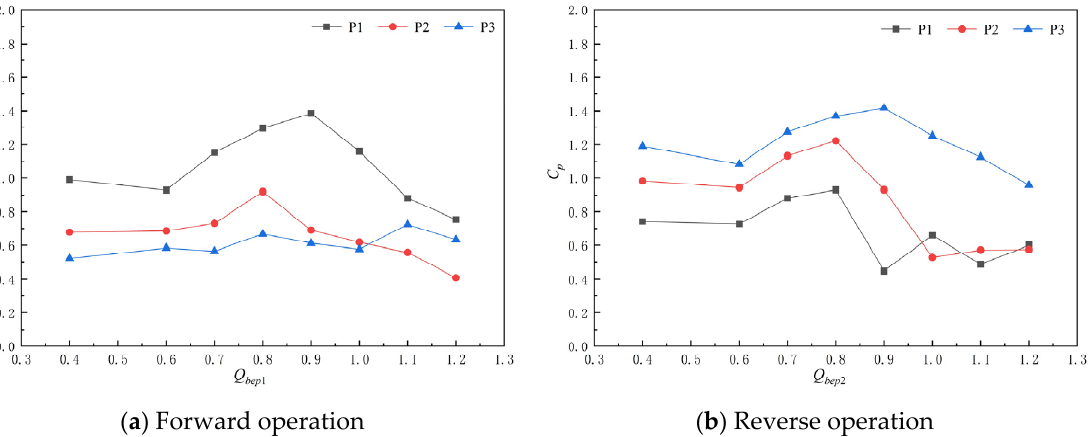
Figure 9. Peak-to-peak value of the pressure pulsation coefficient in the monitoring points of bidirectional axial flow pump under different flow conditions.